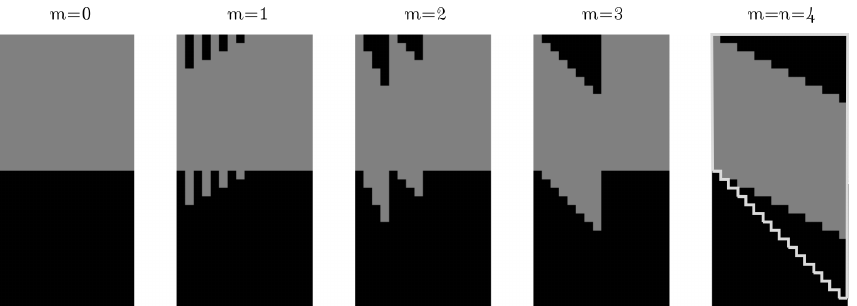
Figure 10. Memory patterns of data required for computing central DRT on a 16 × 16 image.